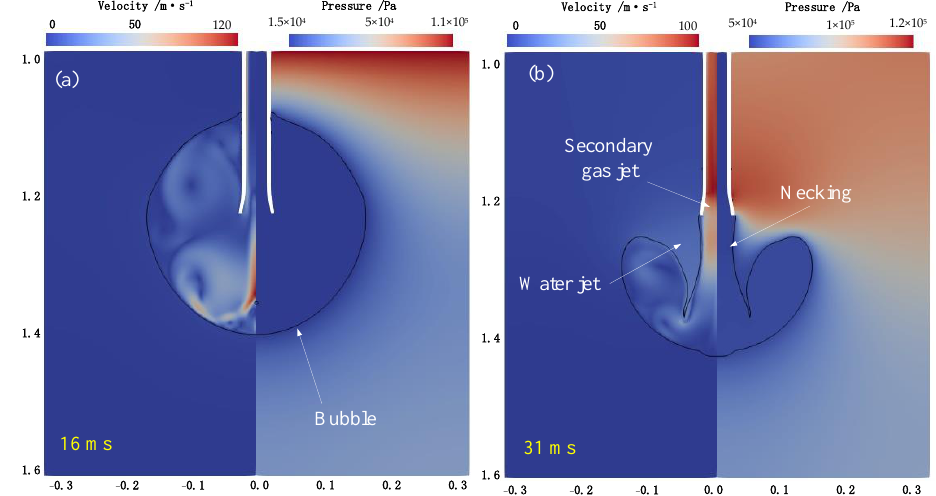
Figure 7. Simulation results of the bubble evolution process when the expanding nozzle was installed: ( a ) t = 16 ms, ( b ) t = 31 ms.